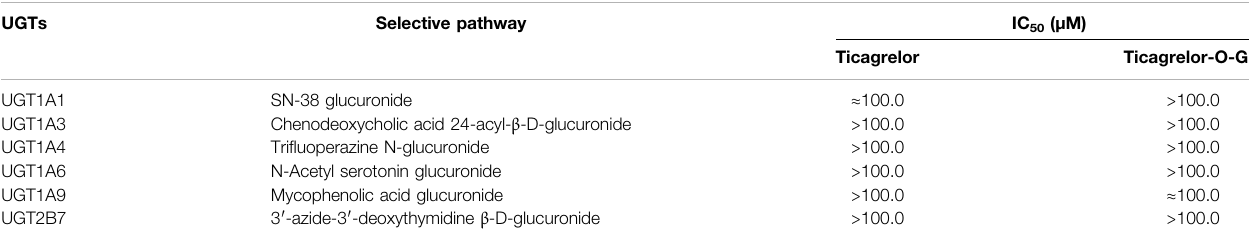
TABLE 2 | UGT-selective metabolic pathways inhibition mediated by ticagrelor and ticagrelor-O-glucuronides. UGTs Selective pathway